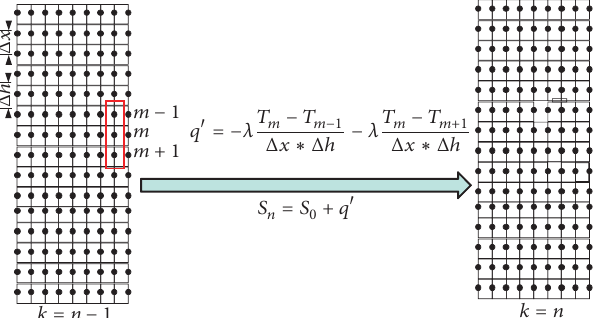
Figure 6: Schematic of the calculation of the axial heat